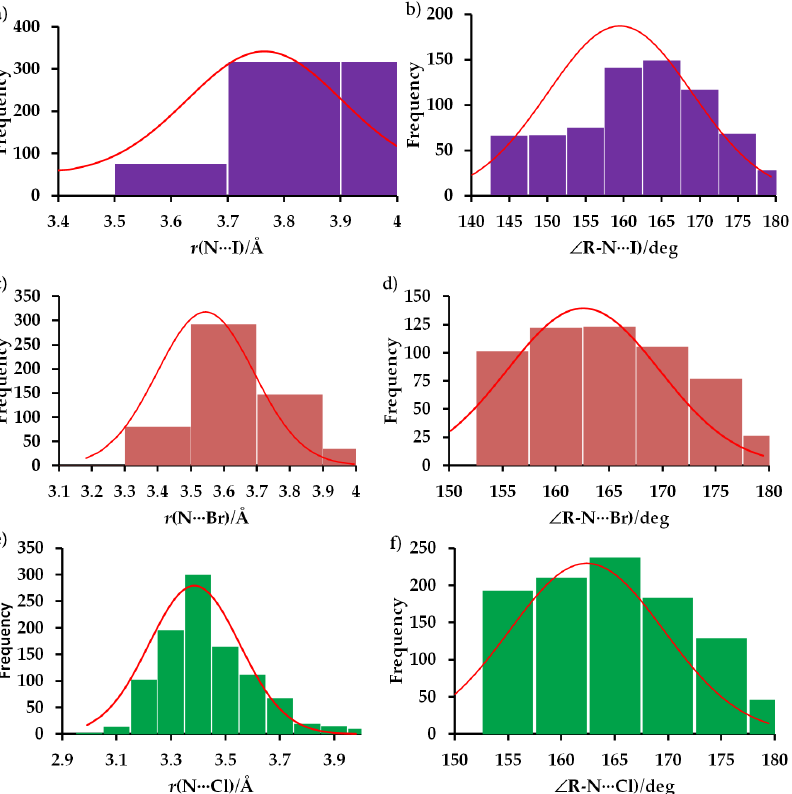
Figure 28. ( a , b ) Histograms illustrating the intermolecular distances r (N ··· I) and intermolecular bond angles ∠ R–N ··· I for 81 hits (89 close contacts) found in a CSD search for the bond distance and bond angle ranges of 2.6–4.0 Å and 170–180 ◦ , respectively. Shown in ( c , d ) are the corresponding plots for 554 close instances from 309 hits for N ··· Br in the bond distance and bond angle ranges of 2.6–4.0 Å and 150–180 ◦ , respectively. Shown in ( e , f ) are the corresponding plots for 1000 close contacts from 658 hits for N ··· Cl in the bond distance and bond angle ranges of 2.6–4.0 Å and 150–180 ◦ , respectively. False contacts in ( a , b ) were removed, but not in ( c – f ). The bell curve in red in each case represents the normal